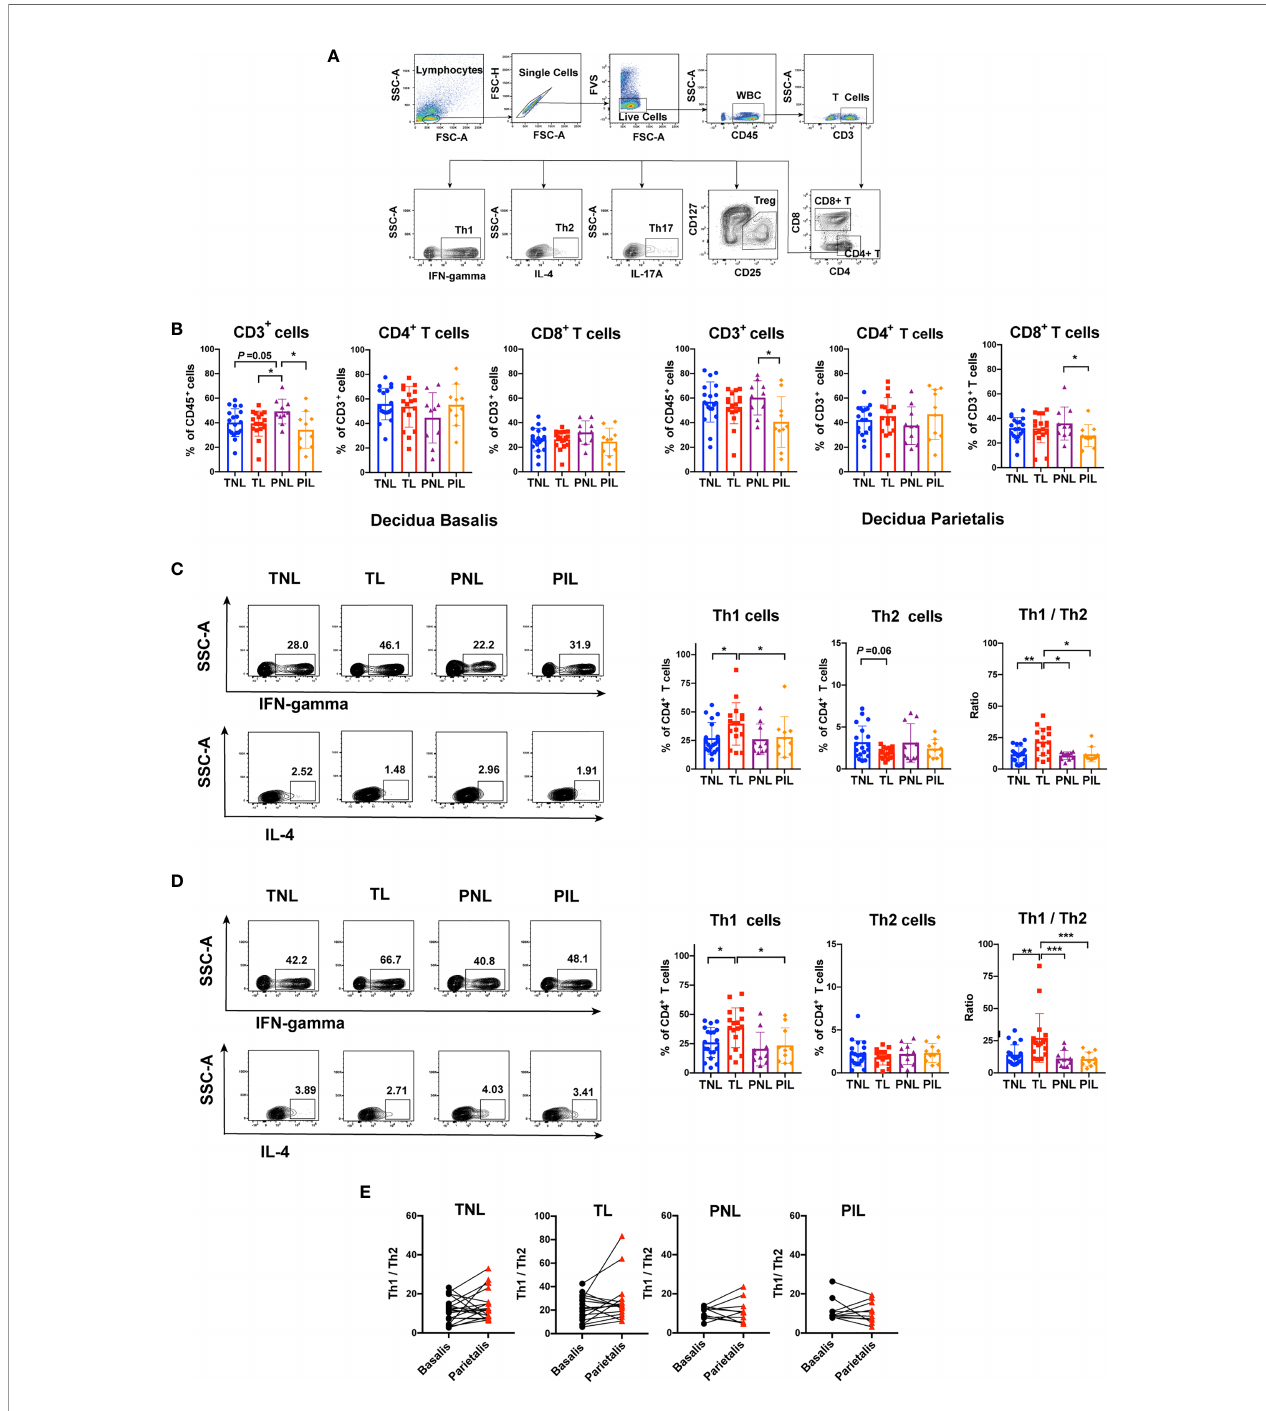
FIGURE 4 | Flow Cytometric Analysis of Th1 and Th2 cells in the Decidua basalis and Parietalis during Term and Preterm Labor. (A) Gating strategy used for determining T cells (CD45 + CD3 + cells), CD4 + T cells, CD8 + T cells, Th1 cells (IFN- g + CD4 + cells), Th2 (IL-4 + CD4 + T cells), Th17 (IL-17A + CD4 + T cells) and Treg (CD25 high CD127 low CD4 + T cells); (B) Comparison of the frequencies of CD3 + cell in CD45 + cells, and the percentages of CD4 + T cells and CD8 + T cells in total T cells among the four groups in the decidua basalis (left) and parietalis (right) tissues; (C) Comparison of the frequencies of Th1 and Th2 cells as well as Th1/Th2 ratio among the four groups in the decidua basalis; (D) Comparison of the frequencies of Th1 and Th2 cells as well as Th1/Th2 ratio among the four groups in the decidua parietalis; (E) Comparison of Th1/Th2 ratio between the decidua basalis and parietalis among the four groups respectively. Continuous variables were presented as mean ± standard deviation. Mann-Whitney U test was used for comparison between two groups, Wilcoxon matched-pairs signed rank test were used for comparison between decidua basalis and parietalis. Differences are indicated: * P < 0.05, ** P < 0.01 and *** P < 0.001. TNL group, N = 19; TL group, N = 17; PNL group, N = 10; PIL group, N =